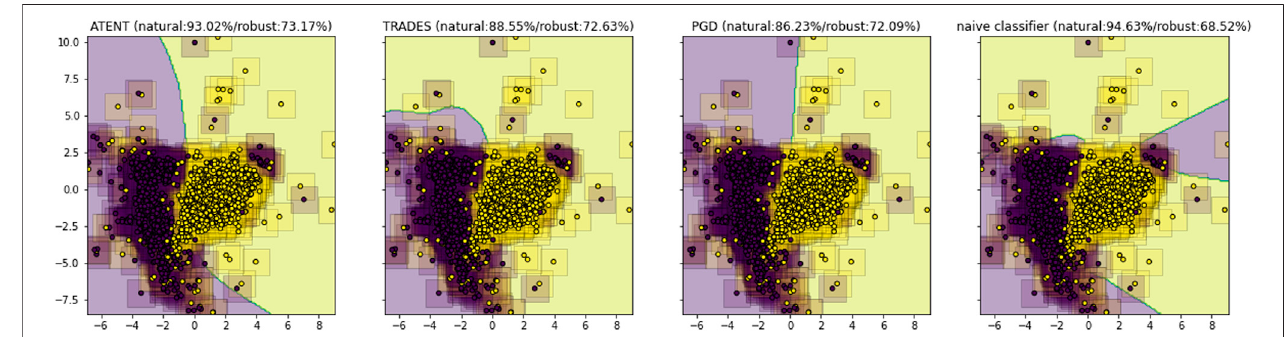
FIGURE 1 | TSNE visualization of decision boundaries for a 3-layer neural network trained using different defenses; corresponding natural and robust test accuracies against ℓ ∞ attacks for classifying MNIST digits 5 and